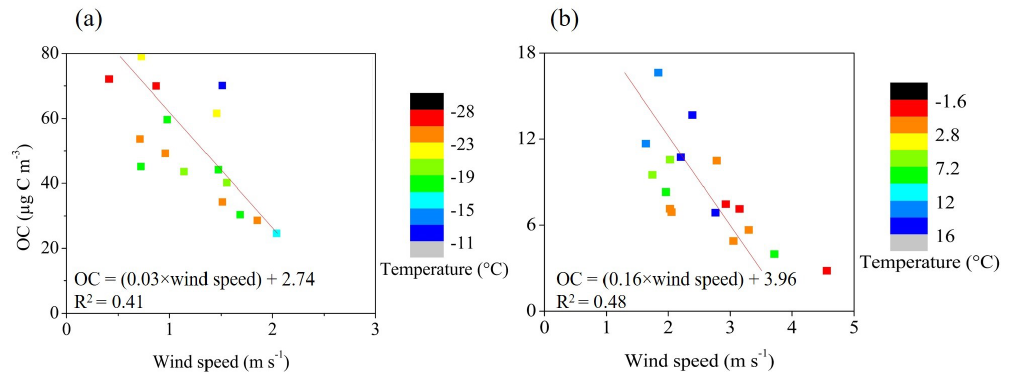
Figure 3. Daily atmospheric concentrations of OC (µgCm − 3 ) as a function of wind speed (ms − 1 ) and temperature ( ◦ C) during winter (a) and spring (b) of 2017.